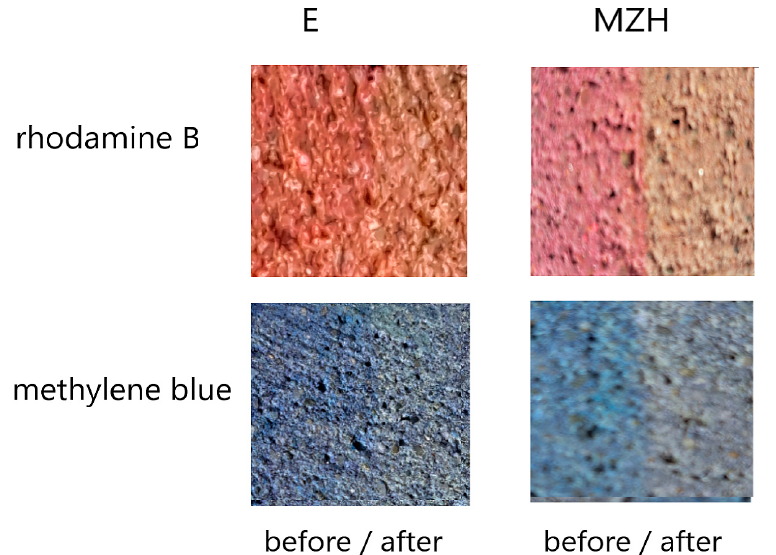
Figure 4. Images of self-cleaning result for plain cement mortar (E) and cement mortar with powder ZnO/Hap (MZH).